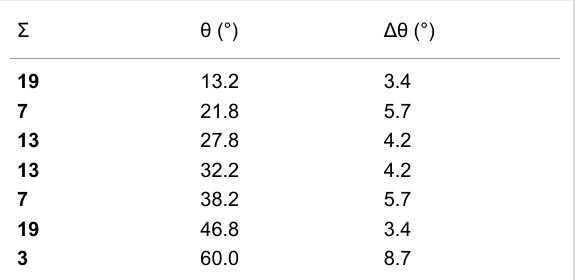
Table 1: Σ -values for CSL lattices generated by misorientations θ about the common <111> rotation axis together with Δθ values according to Equation 4.